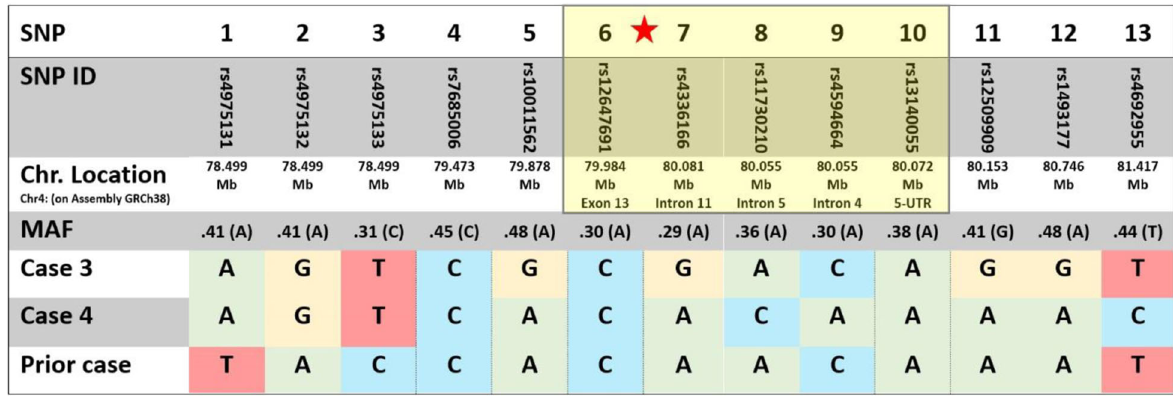
Table 2 Haplotype analysis in cases with the c.1073dup mutation in ANTXR2 gene